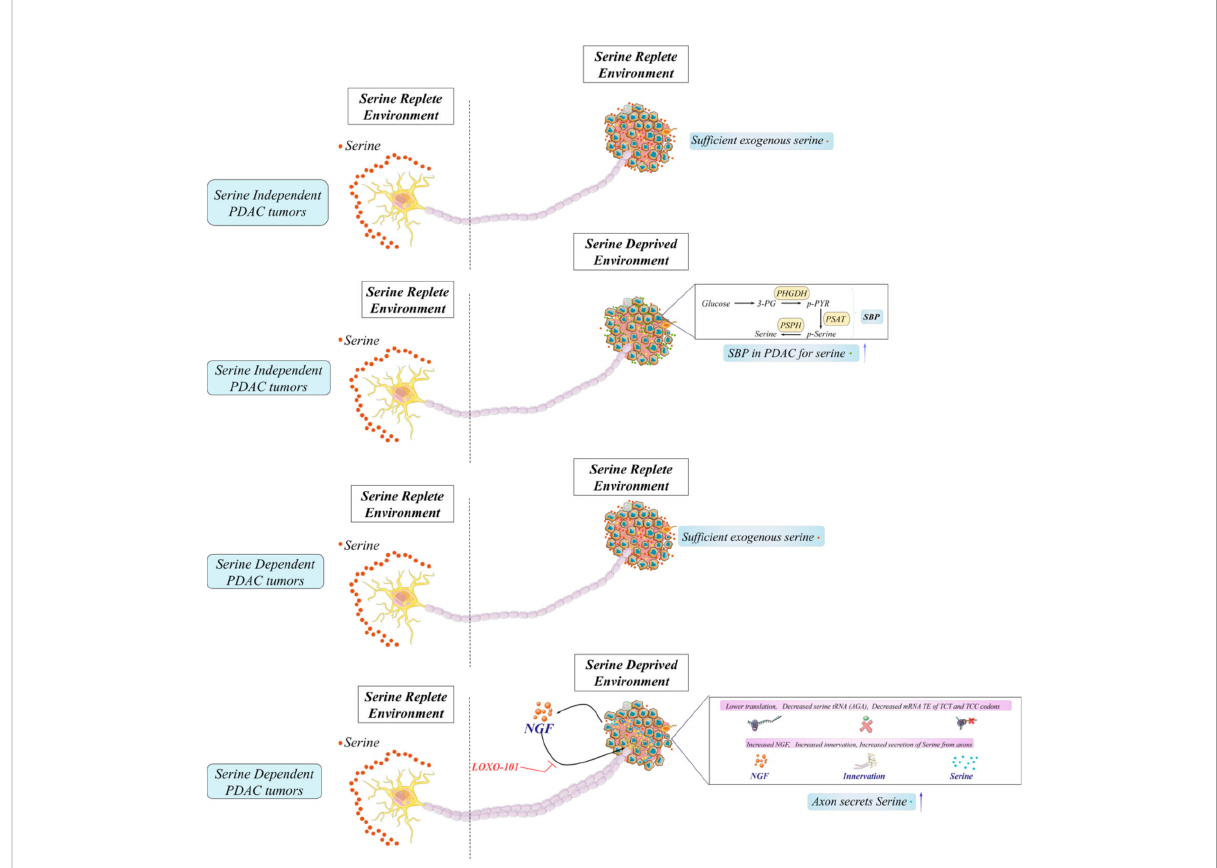
FIGURE 4 Neural and metabolic interactions in pancreatic ductal adenocarcinoma (PDAC). A large fraction of human PDAC cells lack SBP enzymes (PHGDH and PSAT-1) and cannot generate serine, and other pathways like autophagy and pancreatic stellate cells cannot generate suf fi cient levels of serine for growth in PDAC cells under serine deprivation. Therefore, these PDAC cells which must import serine for growth are exogenous serine-dependent PDAC. Moreover, those with SBP enzymes (PHGDH and PSAT-1) for the generation of serine from glucose are exogenous serine-independent PDAC. To date, neurons could directly promote metabolic support (releasing serine) for PDAC cells under the serine-deprived conditions in